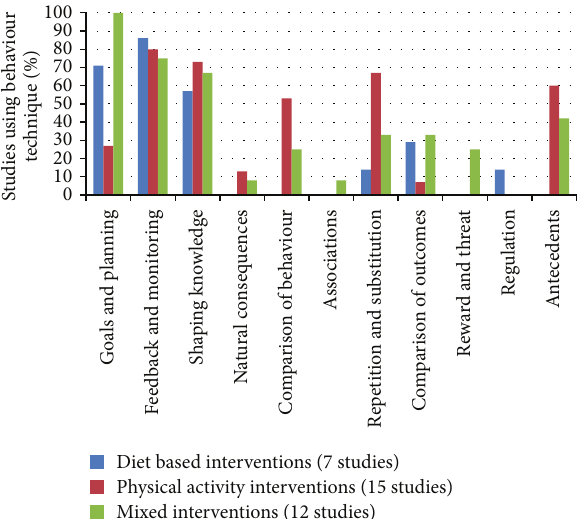
Figure 2: Behaviour change technique taxonomy categories accord- ing to intervention type ( 𝑛 = 34